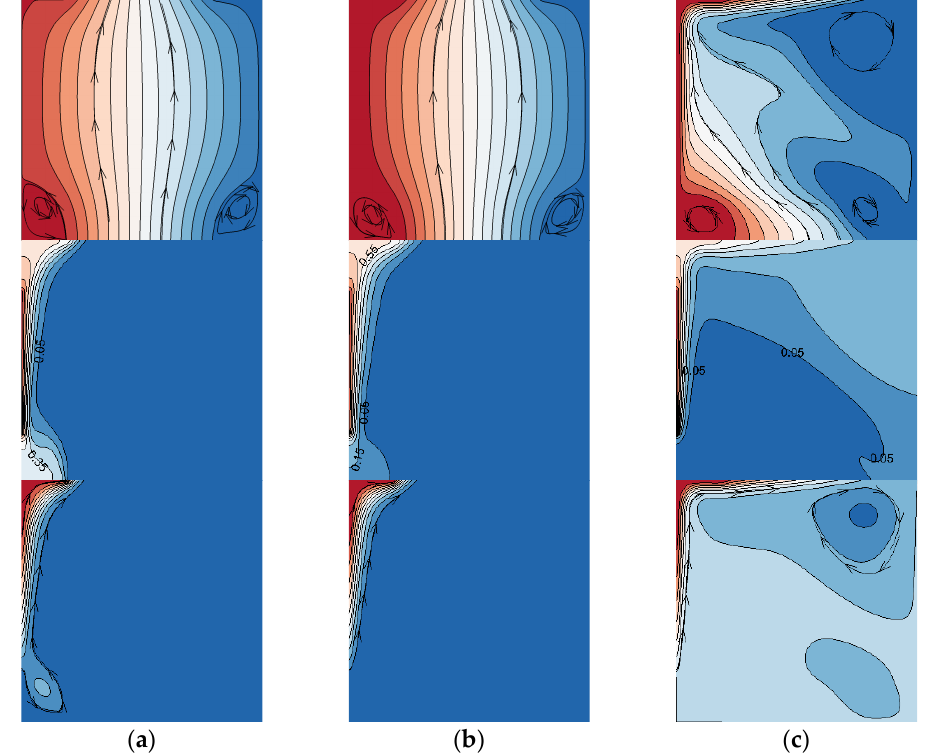
Figure 10. Contours of streamlines, isotherms, and heatlines (from top to bottom) with Left side arrangement of heat source (Type D). ( a ) Ri = 0.01, ( b ) Ri = 0.4, and ( c ) Ri = 100.